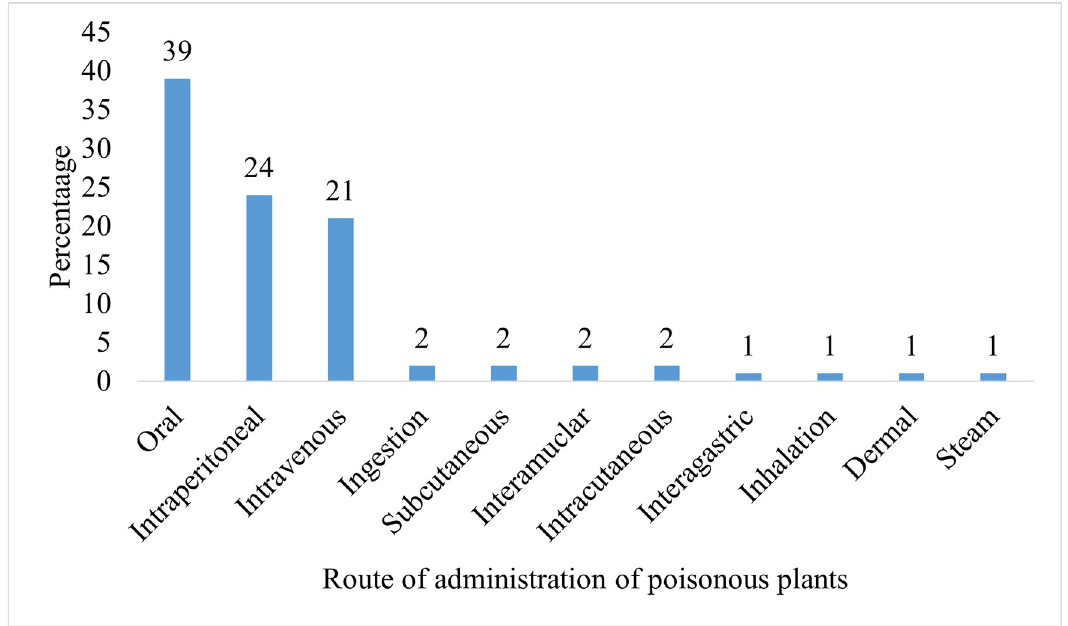
Fig 6. Different routes of administration of plant